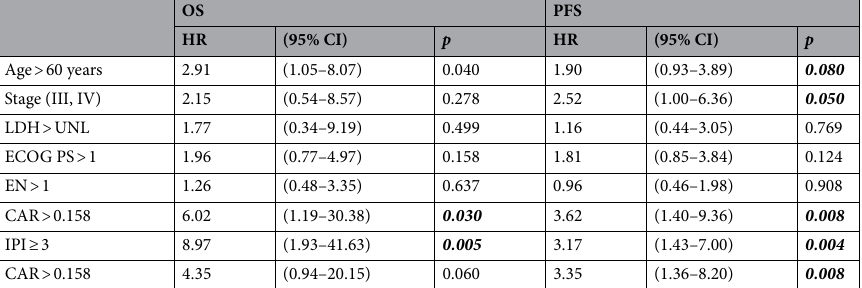
Table 3. Multivariable analyses of overall survival and progression-free survival in patients with available pre-treatment C-reactive protein-to-albumin ratio data. OS overall survival, PFS progression-free survival, HR hazard ratio, CI confidence interval, LDH lactate dehydrogenase, UNL upper normal limit, ECOG PS Eastern Cooperative Oncology Group performance status, EN extranodal, CAR C-reactive protein-to-albumin ratio, IPI international prognostic index.